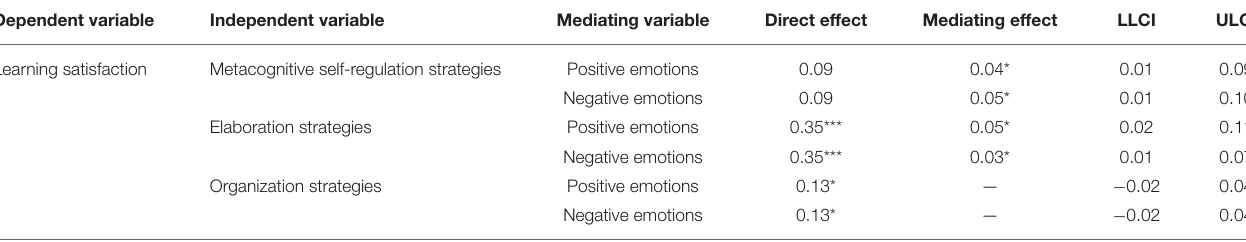
TABLE 4 | Bootstrapping analysis of the mediating effect test.